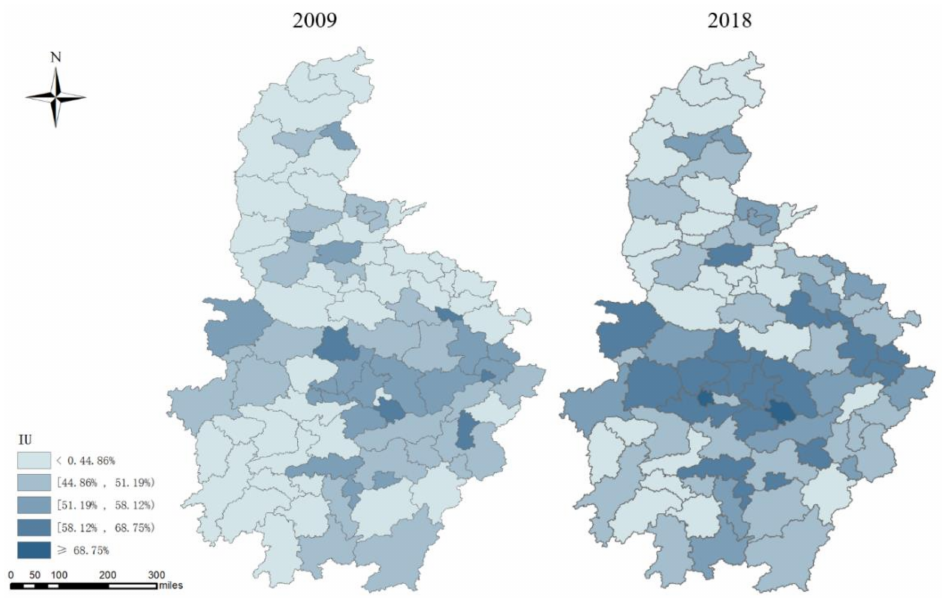
Figure 2. Spatial distribution of in situ urbanization rate in central